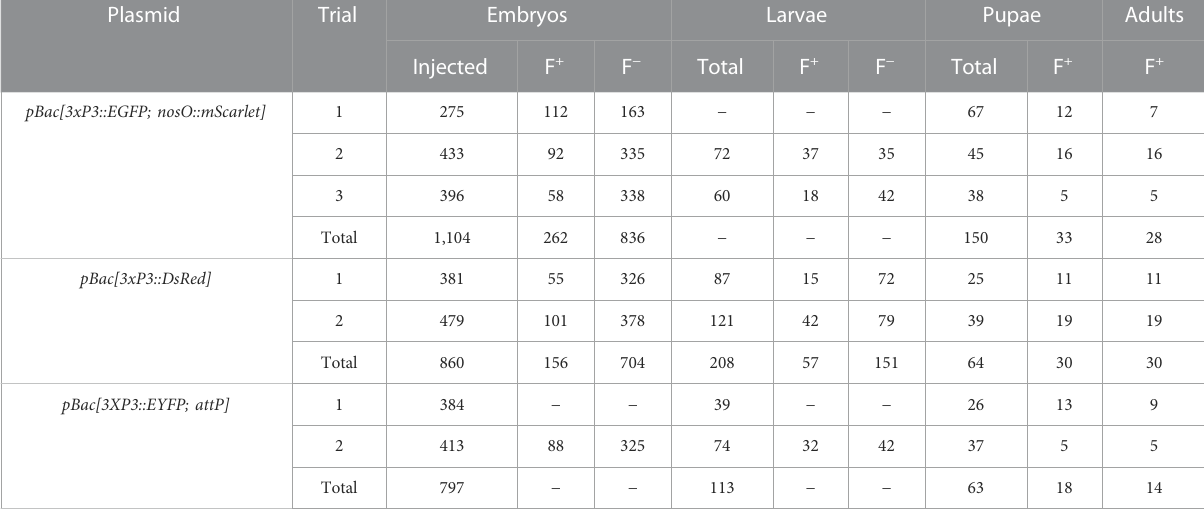
TABLE 1 G 0 phenotypes of Plodia injected with pBac donor plasmids and hyPBase transposase mRNA. Plasmid Trial Embryos Larvae